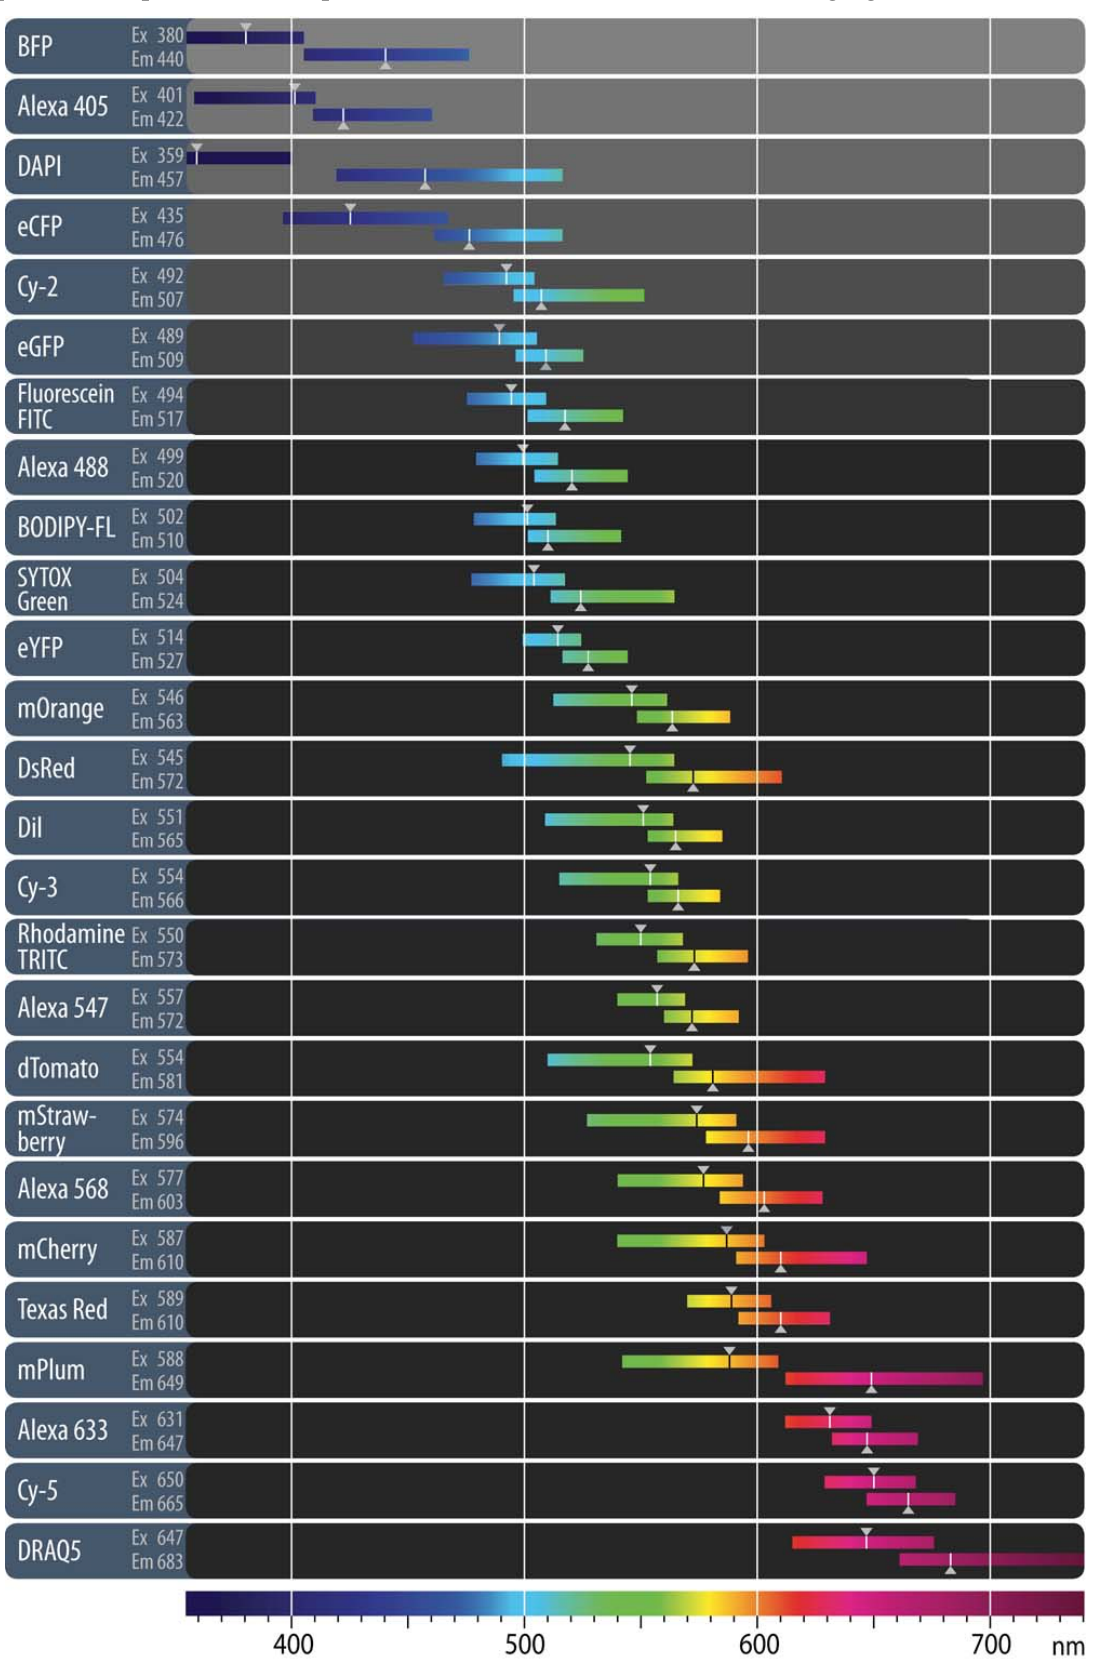
Table 1. Overview of the fluorescent properties of popular organic dyes and fluorescent proteins. Reproduced with permission. © 2011 Carl Zeiss Micro-Imaging